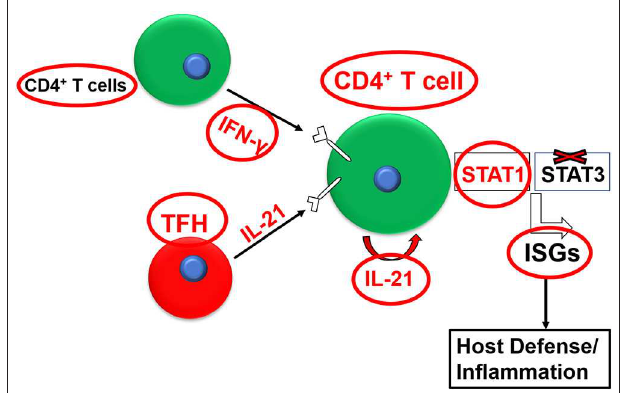
FIGURE 1 | Synergy between the IL-21/IL-21R and the IFN- γ /IFN γ R pathways for the optimal expression of interferon-stimulated genes (ISGs).